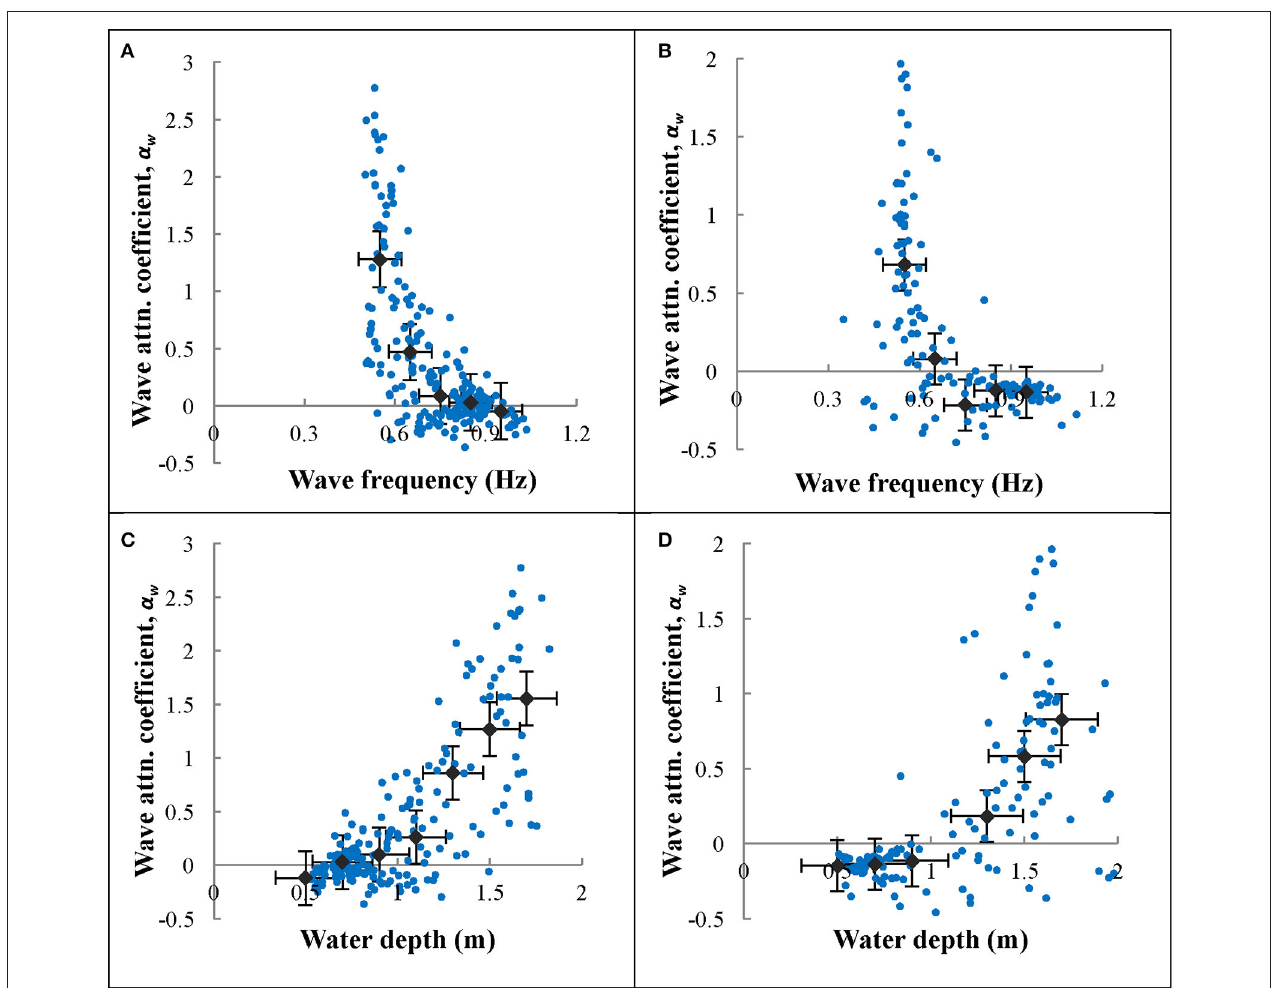
FIGURE 5 | Wave frequency vs. wave attenuation coefficient ( α w ) for north winds during (A) summer 2012 and (B) winter 2013. Raw data are presented in green points. Data were averaged in 0.1Hz bins and averages were plotted along with the raw data as gray diamonds. Water depth vs. wave attenuation coefficient ( α w ) for north winds during (C) summer 2012 and (D) winter 2013. Raw data are presented as purple points. Depth data were averaged in 0.01m bins and plotted along with the raw data as gray diamonds. Means that had fewer than 10 data points in a bin were excluded from the plots. Error bars on the averaged data show standard